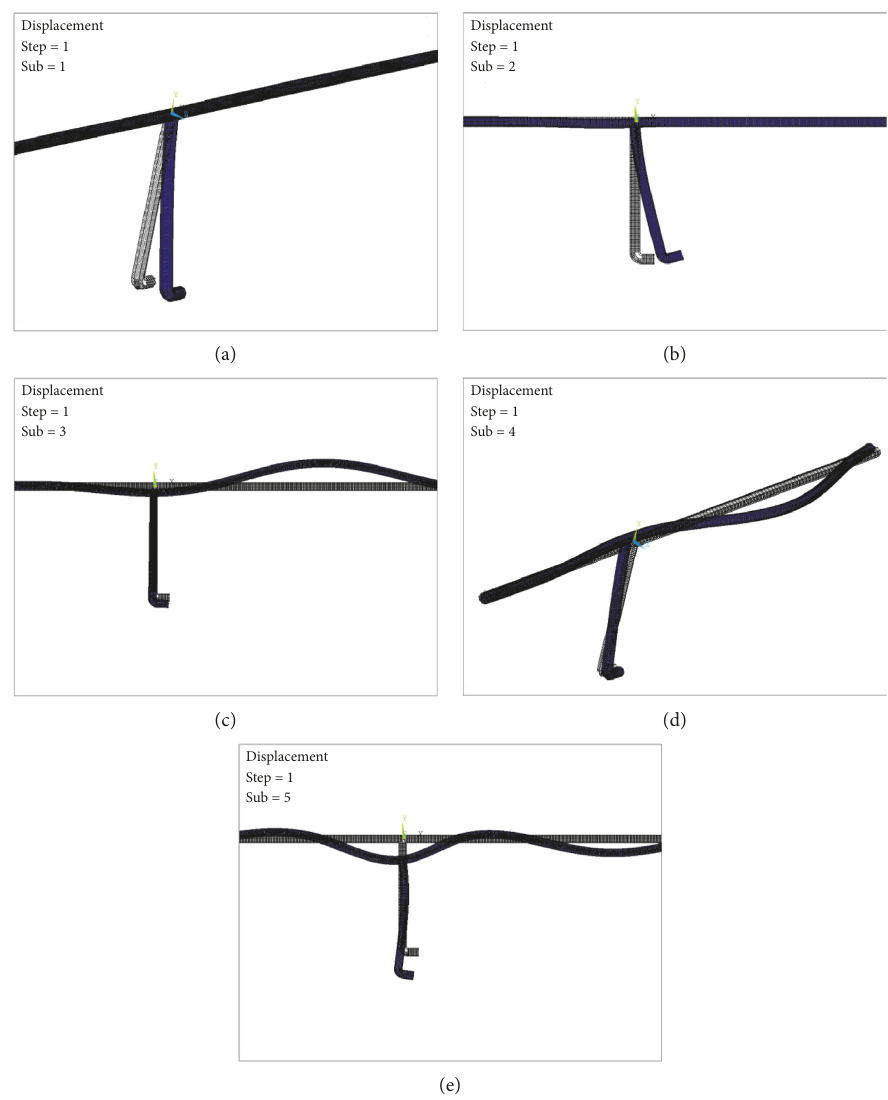
Figure 8: First five order mode shapes of the pipeline structure: (a) first-order mode shape, (b) second-order mode shape, (c) third-order mode shape, (d) fourth-order mode shape, and (e) fifth-order mode